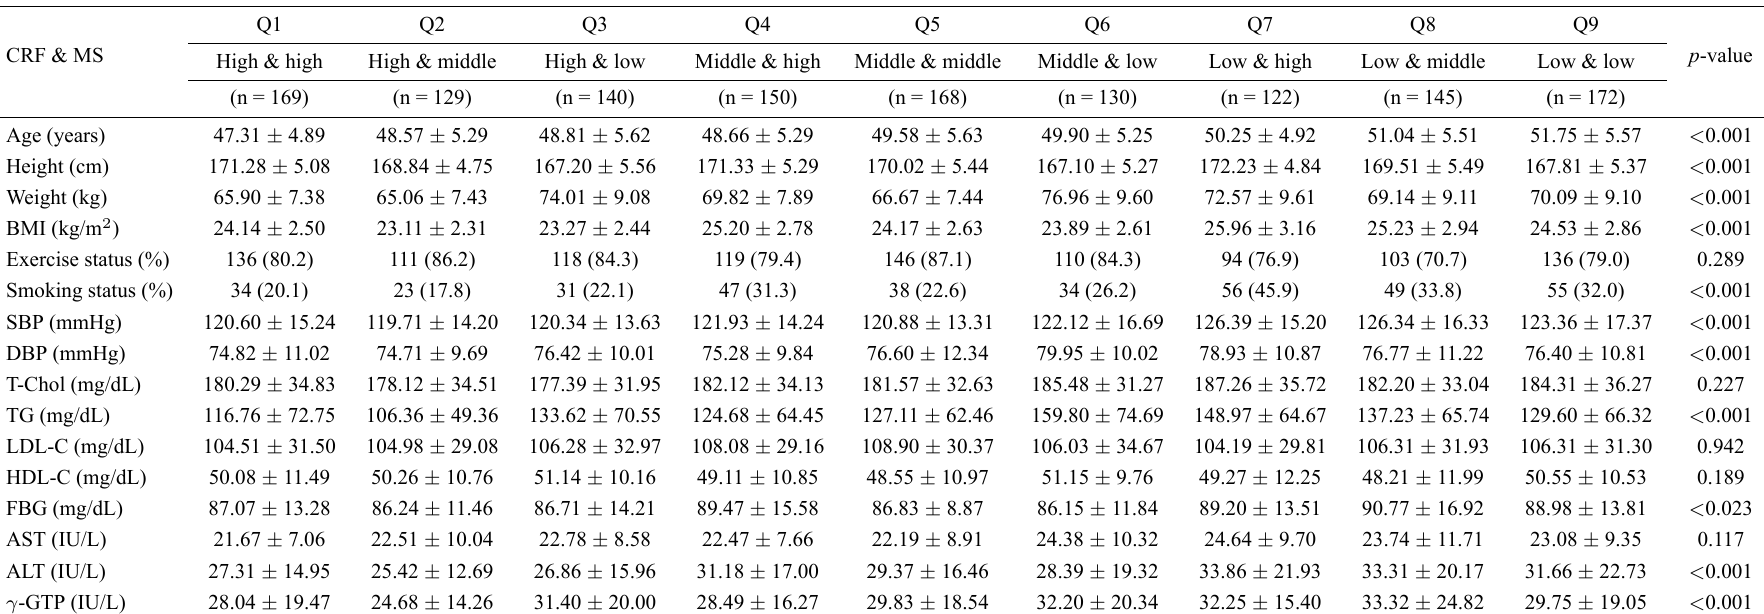
Table 3. Clinical characteristics in accordance with cardiovascular fitness and muscle strength levels (Q1–Q9).